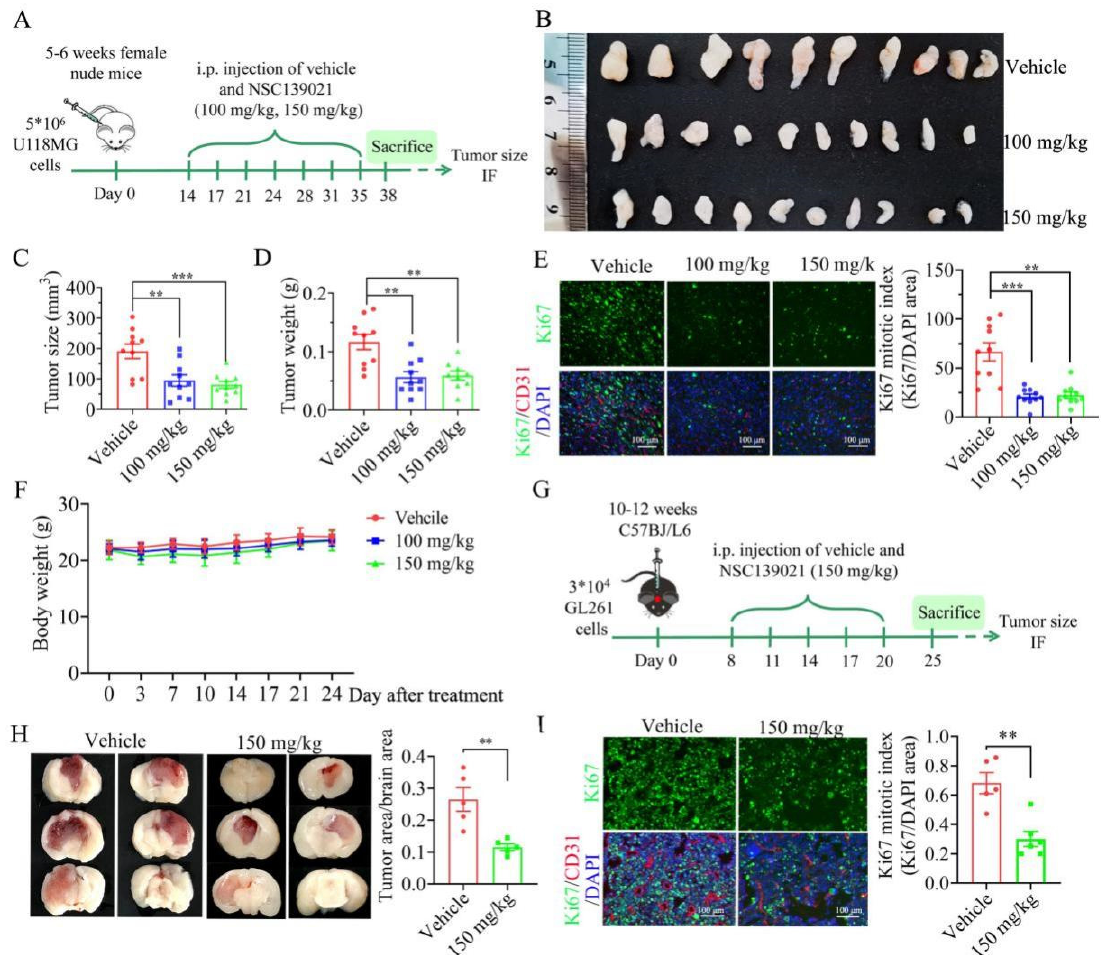
Figure 5. NSC139021 treatment inhibited the growth of glioblastoma in vivo. ( A ) The schematic representation of glioblas- toma model with subcutaneous injection of U118MG cells. ( B ) Images of xenograft tumors in vehicle and NSC139021 (100 and 150 mg/kg) groups ( n = 10 per group). ( C ) Tumor size at the end of the experiment ( n = 10 per group). ( D ) Tumor weights at the end of the experiment ( n = 10 per group). ( E ) Ki67/CD31/DAPI immunofluorescence (IF) staining of U118MG tumor (left panel). Quantification of Ki67-positive cells by calculating the ratio of the Ki67 IF staining-positive area to the DAPI area (right panel). ( F ) Changes in body weight during the NSC139021 administration period. ( G ) The schematic representation of glioblastoma model with orthotopic transplantation of GL261 cells. ( H ) Images of GL261 tumors in vehicle and NSC139021 (150 mg/kg) groups. Image J analysis indicated the ratio of tumor size with brain size was decreased in the NSC139021 group ( n = 5 per group). ( I ) Ki67/CD31/DAPI co-IF staining of GL261 tumors (left panel). Quantification of Ki67-positive cells by calculating the ratio of the Ki67 IF staining-positive area to the DAPI area (right panel). ( n = 5~6 per group). The data were represented as the mean ± SEM, ** p < 0.01, *** p < 0.001, when compared to the vehicle group.